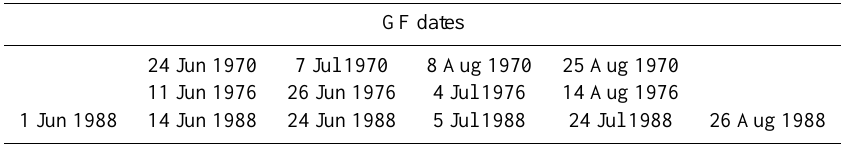
Table 1. Events selected from + σ winters (JJA) (adapted from M¨uller et al., 2005).